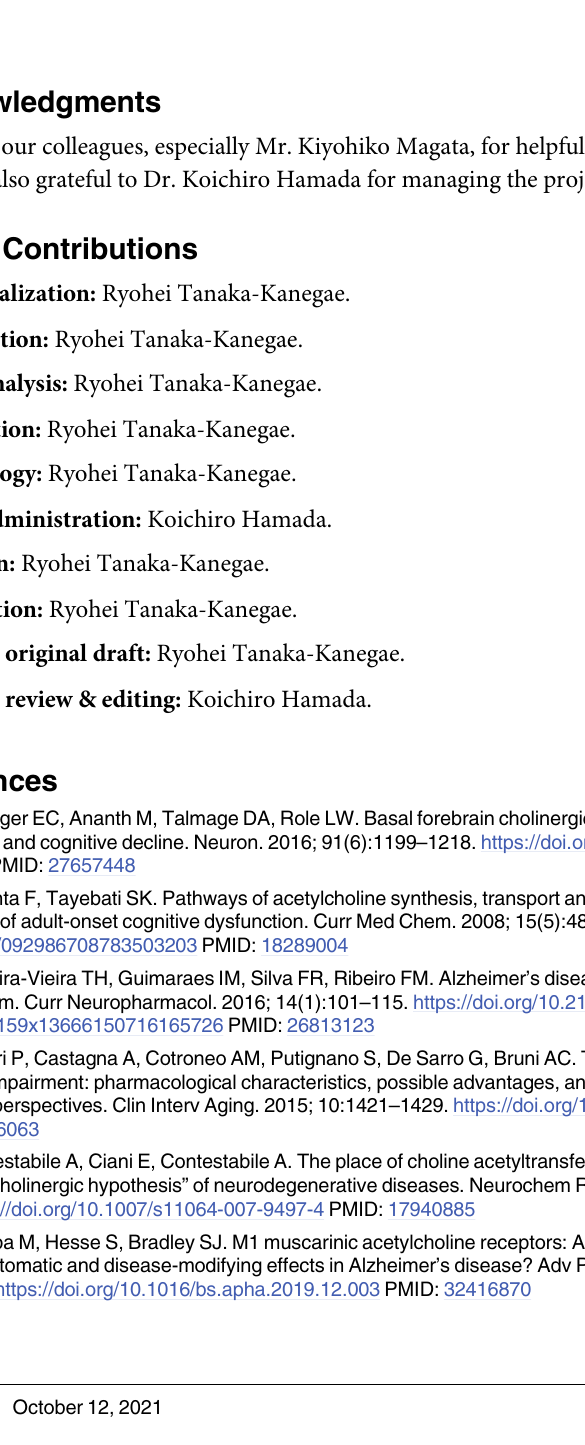
S1 Dataset. A dataset for choline and acetylcholine quantification. (XLSX) S1 Raw image. The raw image of western blot. Fig 1 was generated from this raw image. We evaluated different lysates of LA-N-2 cells that were harvested another day, and confirmed the reproducibility of the expression of mAChR M2. S2 Raw image. The raw image of western blot. The same membrane as S1 Raw image but with longer exposure time to increase the intensity of bands of the molecular weight marker.